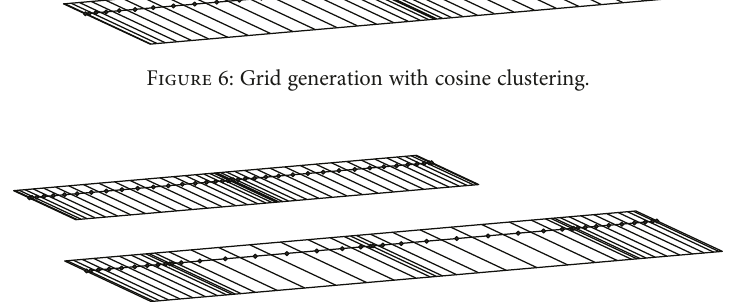
Figure 7: Grid generation with independent clustering.